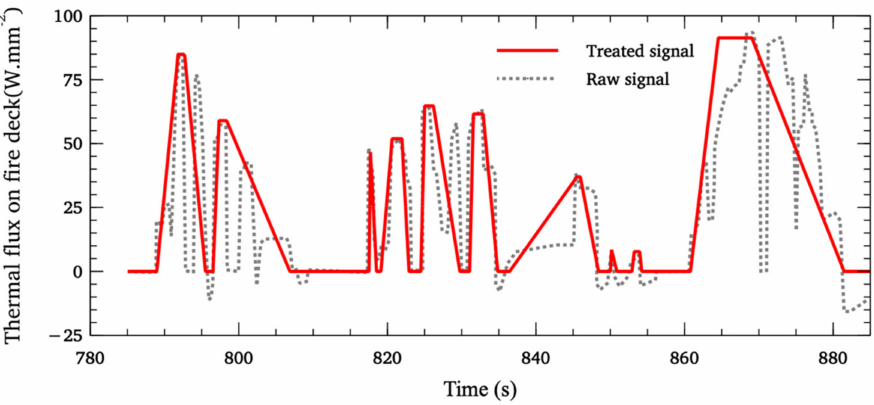
Figure 5. Evolution of thermal flux on cylinder head fire deck with time and signal processing for TMF design